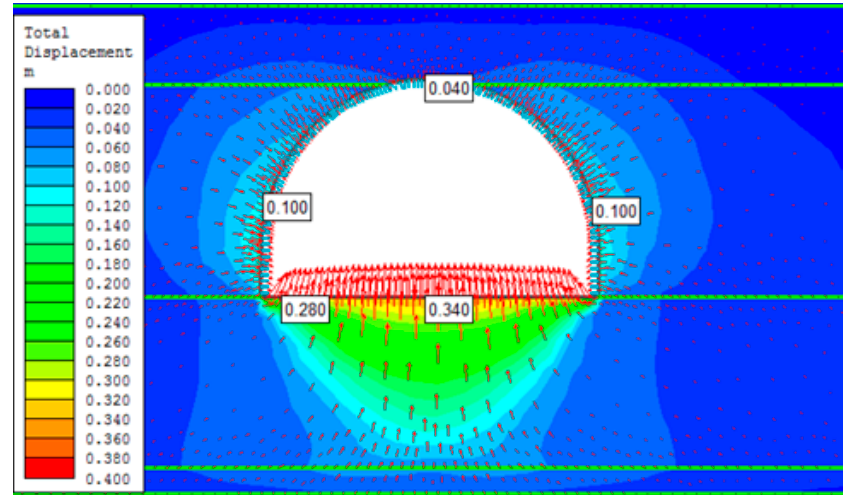
Figure 9. Model no. 1—elasto-plastic—map of total displacements.